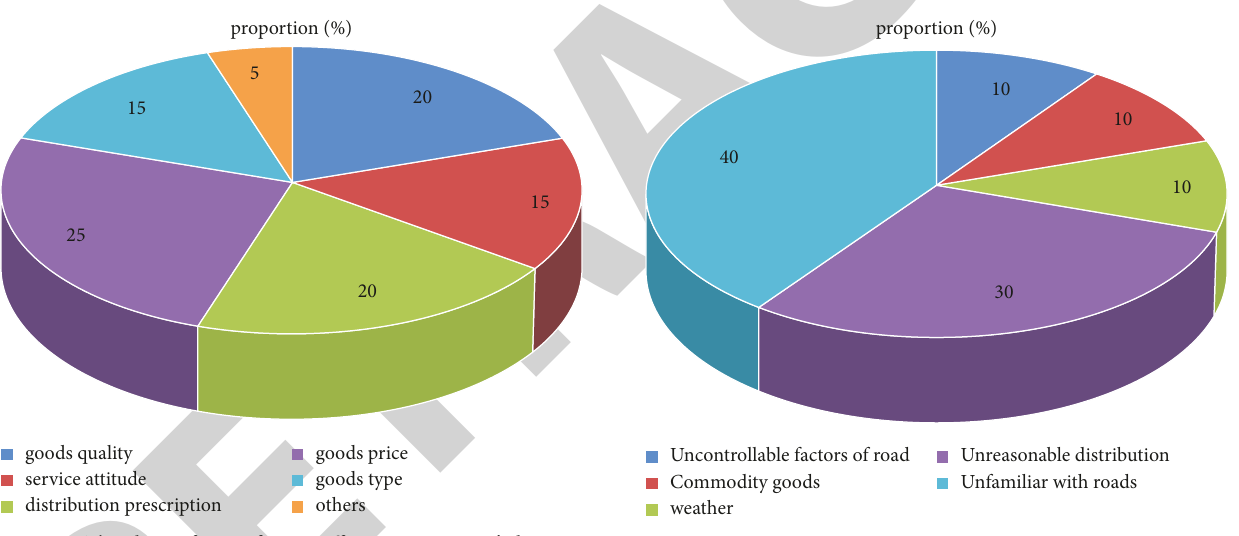
Figure 5: The chart of main factors affecting the distribution ef- ficiency of